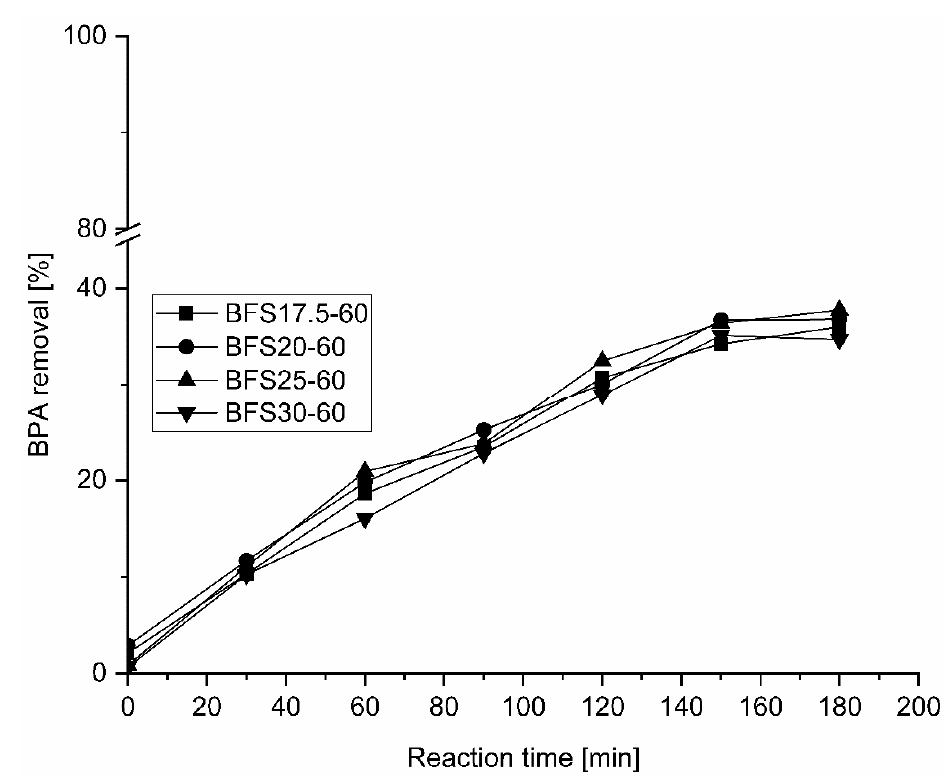
Figure 4. Removal of bisphenol A over AAMs as a function of the reaction time. Reaction conditions: concentration [ c ], c [BPA] = 60 mg/dm 3 , c [H 2 O 2 ] = 1.5 g/dm 3 , c [catalyst] = 4 g/dm 3 , temperature [ T ] = 50 ◦ C, initial pH (6–7).